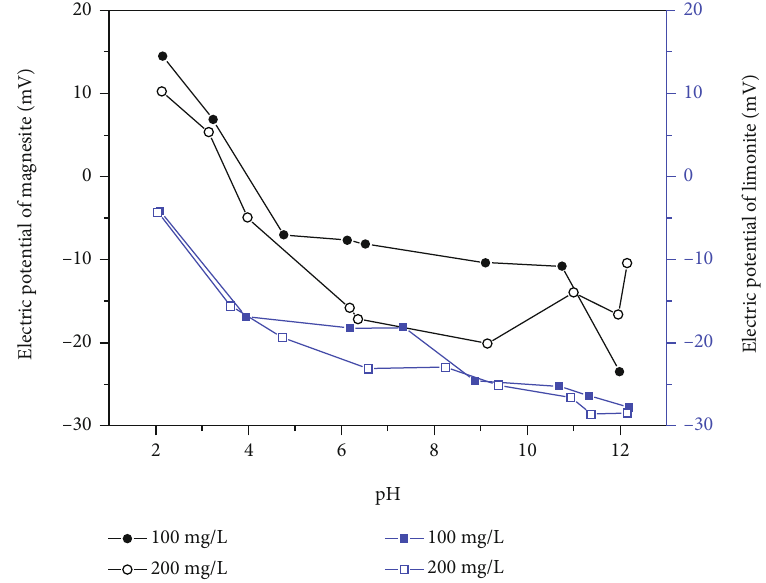
Figure 9: E ff ect of sodium silicate dosage on the zeta potential of magnesite and